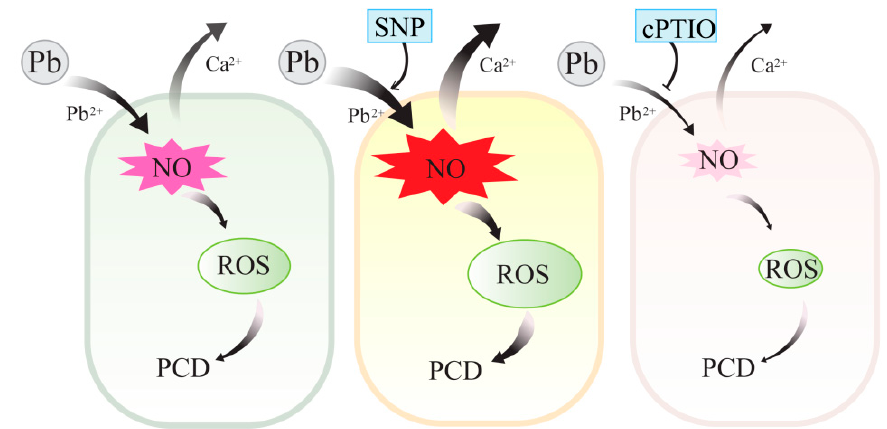
Figure 9. A schematic graphic of NO function in enhancing cytotoxicity of Pb by modulating the generation of ROS, promoting Pb 2 + influx into the cells, and disturbing the Ca 2 + homeostasis. Supplementary Materials: The following are available online at http: // www.mdpi.com / 2223-7747 / 8 / 10 / 403 / s1, Method: TUNEL assay, Figure S1: Typical cells with nuclei containing condensed or granular chromatin. Hoechst 33342 staining in cultured tobacco BY-2 cells treated with 250 µ M Pb(NO 3 ) 2 for 24 h. Scale bar = 50 µ m, Figure S2: Programmed cell death detection using the TUNEL assay. Tobacco BY-2 cells that received the same volume of distilled water were used as a control. Four-day-old tobacco BY-2 cells were treated with di ff erent concentrations (100, 250, and 500 µ M) of Pb(NO 3 ) 2 for 24 h. Left column: TUNEL images; middle column: PI images; right column: merged images of TUNEL and PI. Scale bar = 100 µ